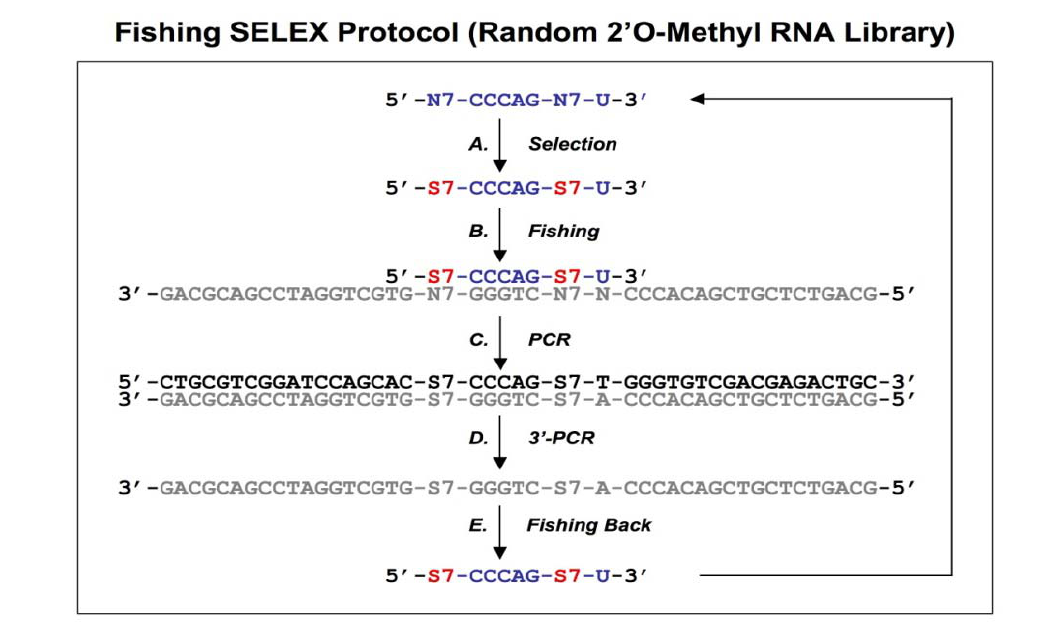
Figure 4 . Diagram of fishing SELEX using a random 2’O-Methyl RNA library. A chemically synthesized random 2’O-Methyl RNA library (indicated in blue) is incubated with target (A), the target bound sequences allow the fishing of the complementary DNA oligonucleotides (B). The fished DNA templates are amplified by regular PCR (C), and then the bottom strand sequences (indicated in gray) are synthesized by PCR using 3’ primers only (D). The amplified bottom strand sequences allow the fishing-back of the 2’O-Methyl RNA sequences, which are used for next round of selection. This protocol is from Boiziau and Toulme